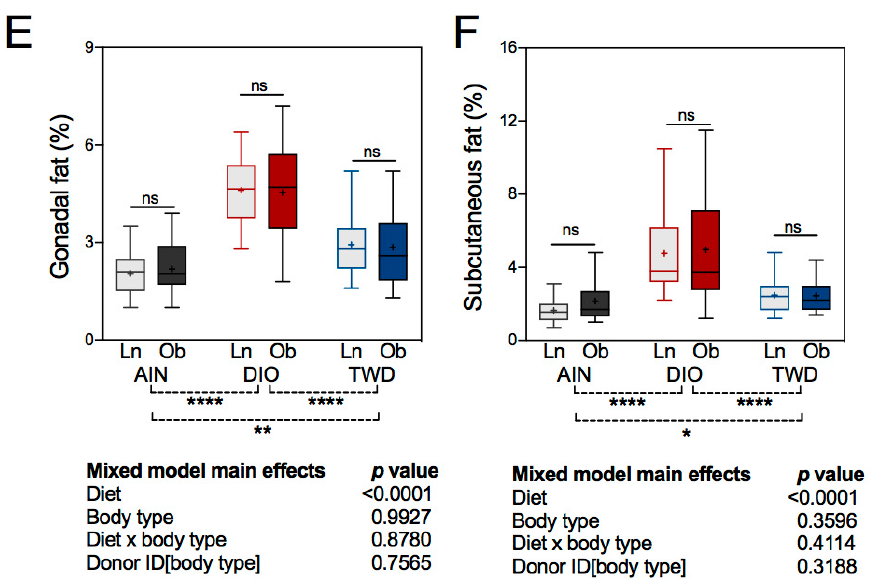
Figure 3. Body composition and fat distribution. Data for lean mass ( A ), fat mass ( B ), lean mass as percent of body weight ( C ), fat mass as percent of body weight ( D ), gonadal fat pad as percent of body weight ( E ), and subcutaneous fat as percent of body weight ( F ) are shown in Tukey box plots (box, 25th to 75th percentiles; whiskers, 1.5 IQR; + , mean) ( n = 6 to 9). The tables below each panel show p -values for the main e ff ects of each experimental factor as determined by the mixed model analysis. Below each plot, brackets indicate the results of Tukey post hoc tests for the overall e ff ects of each diet. Within each diet group, symbols above the box and whisker bars indicate the results of post hoc tests comparing mice that received bacteria from lean (Ln) or obese (Ob) human donors. * p < 0.05, ** p < 0.01, **** p < 0.0001, ns = not